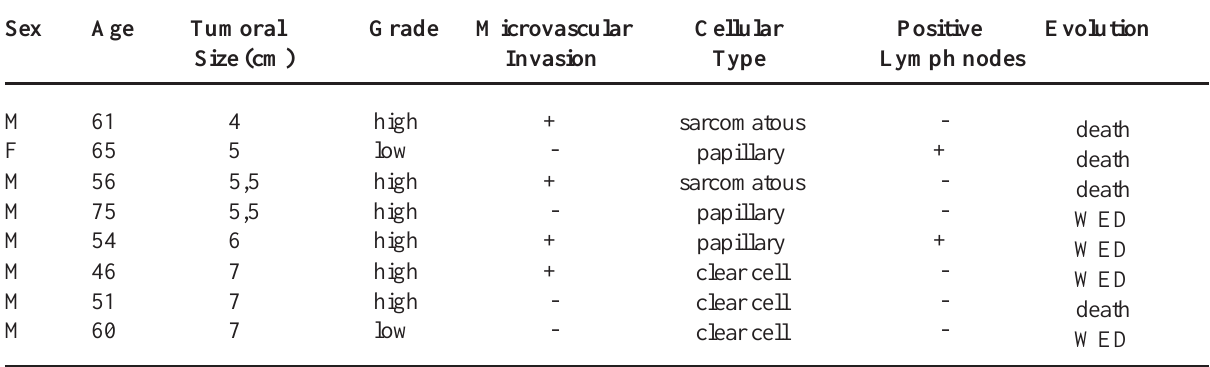
Table 2 – Demographic data for the 8 recurrences in